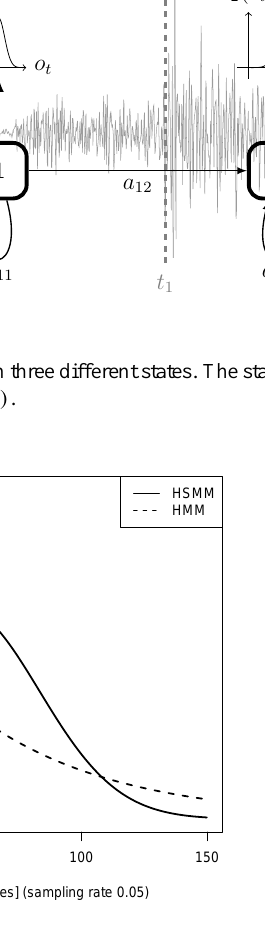
Fig. 3. Exponential (HMM) versus Gaussian (HSMM) state dura- tion probability